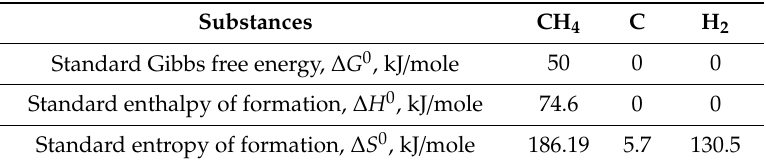
Table 1. Standard values of the Gibbs free energy, enthalpy and entropy of formation of substances involved in Reaction (1)